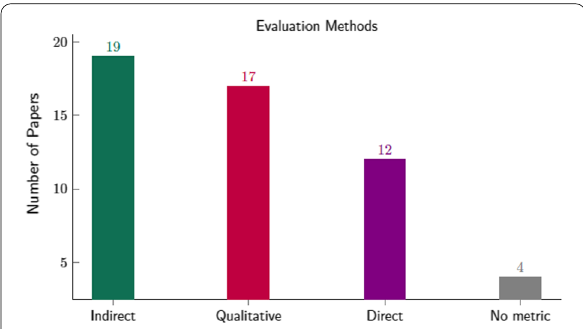
Fig. 10 Evaluation methods for assessing the generative process: an indirect metric for the downstream task (i.e., classification, segmentation, detection, etc.) where is calculated the performance prior to and after sample generation. Qualitative analysis is where expert clinicians assess the generated images with statistical methods or the via Visual Turing Test. Direct assessment of generated samples with image quality metrics (e.g., MSE, FID, IS, etc.), and studies without any metric